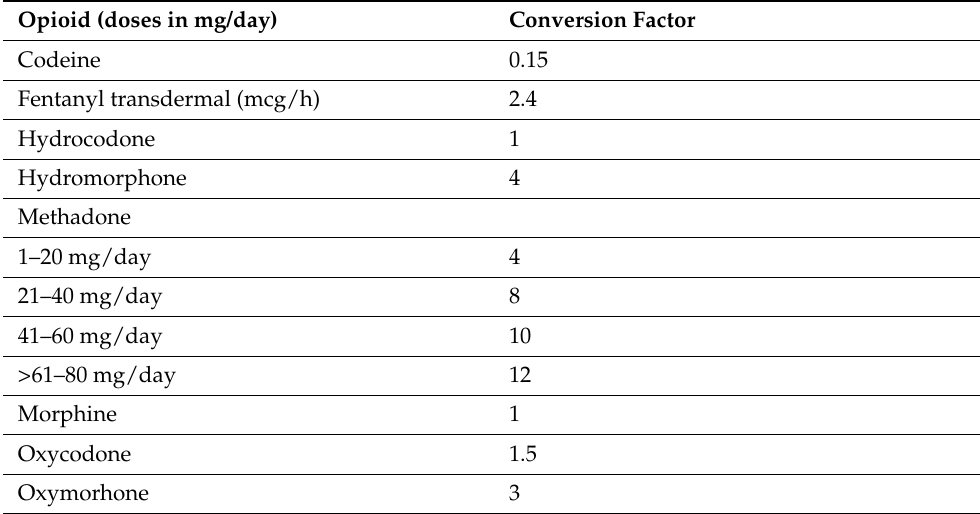
Table 1. Calculating morphine milligram equivalent